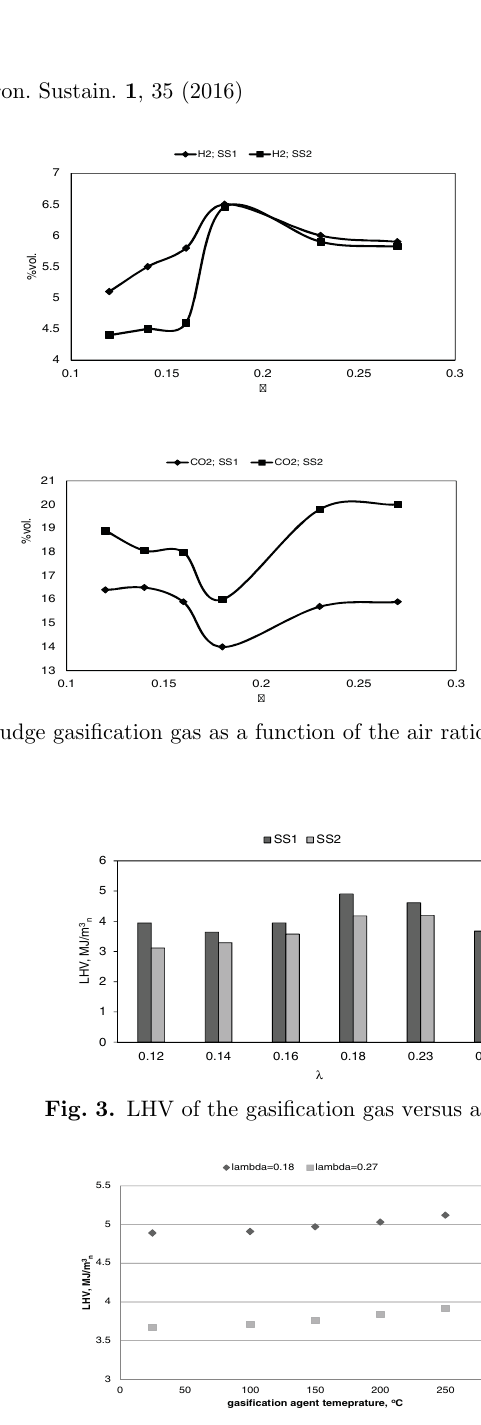
Fig. 4. In fl uence of the gasi fi cation agent temperature on the LHV of the